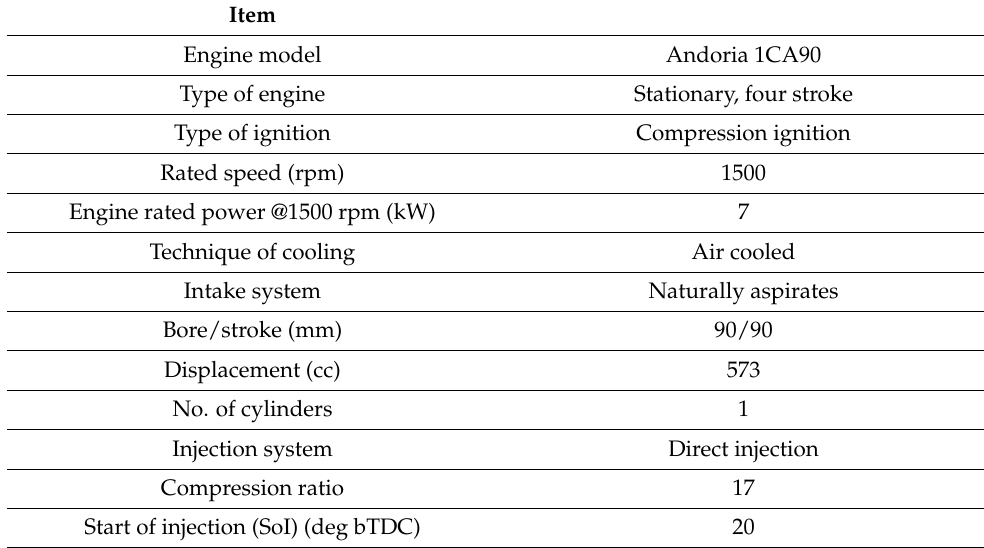
Figure 1. Andoria 1CA90 engine on a test stand ( a ) and schematic arrangement of the engine test stand, instrumentation, and data logging system ( b ). Table 1. Main technical specifications of the test